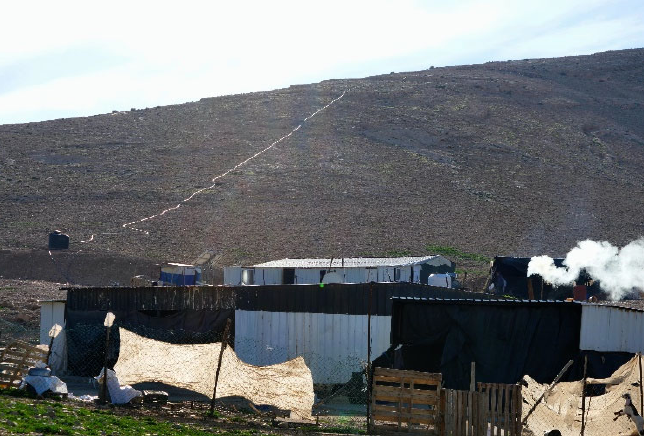
Figure 4. Makeshift structure for Bedouin residence in the “Negev,” desert environment,